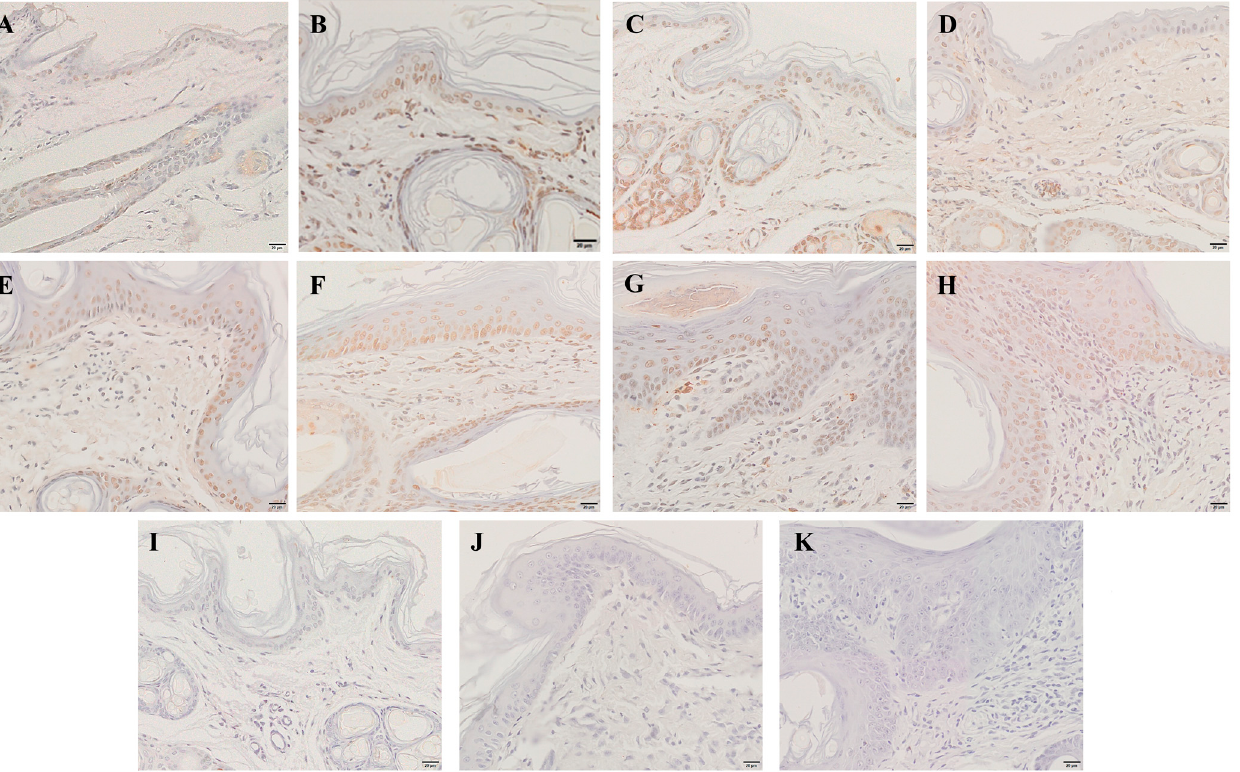
Figure 5. TUNEL staining for the apoptosis of skin cells. ( A ) TUNEL staining of the skin before artificial infestation (control). ( B – H ) TUNEL staining for skin artificially infested for 6 h, 12 h, 1 d, 3 d, 1 w, 4 w, and 8 w. ( I – K ) Negative control. Brownish-yellow nuclei cells are the TUNEL-positive cells. Scale bar = 20 μ m.